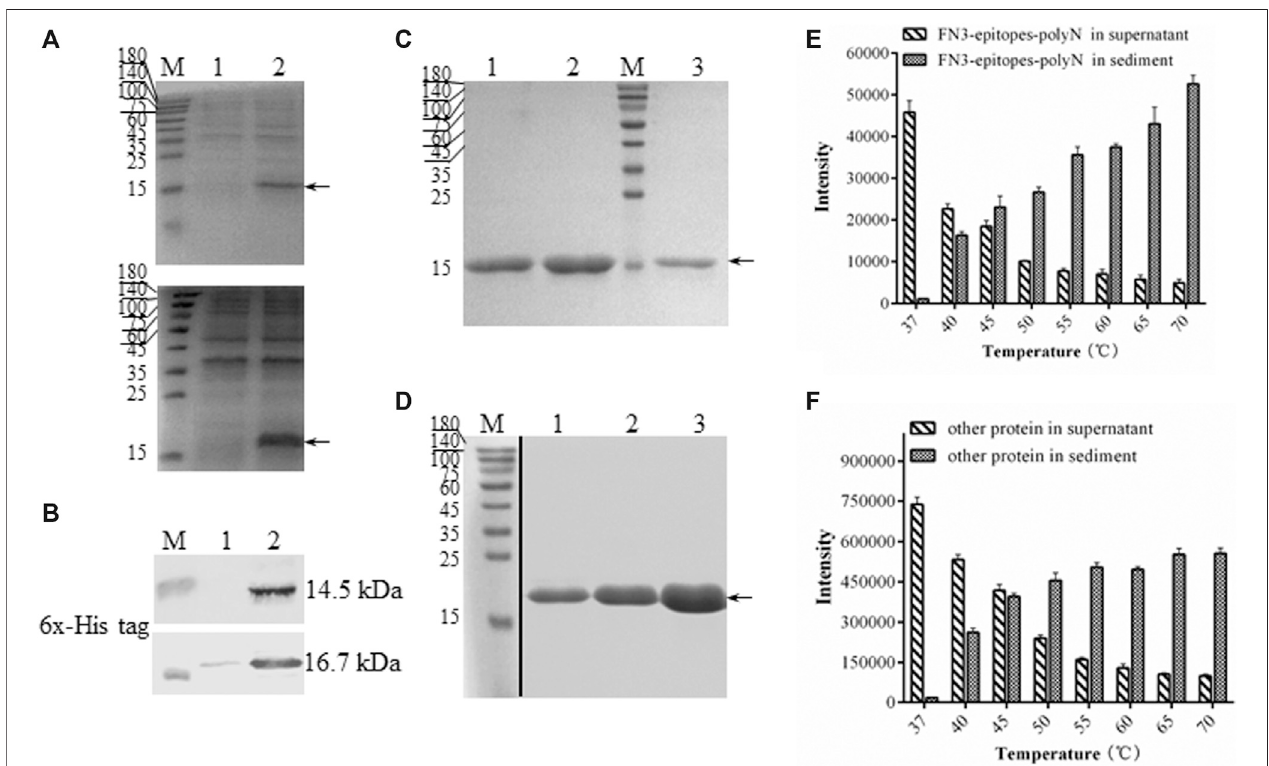
FIGURE3| Thesolubilityandpuri fi cation ofrecombinant FN3-epitopes. (A) SDS-PAGEanalysisofthesolubleexpression ofFN3-epitopes-4GS(upperpanel)and FN3-epitopes-polyN (lowerpanel) in E.coli BL21 (DE3).Arrow indicates thetarget protein FN3-epitopes-4GS (14.5 kDa) orFN3-epitopes-polyN (16.7 kDa). Lane 1:the precipitateoftotalproteinlysates;Lane2:thesupernatant oftotalproteinlysates. ( B )Westernblotanalysisofthesolubleexpression ofFN3-epitopes-4GS(upperpanel) and FN3-epitopes-polyN (lower panel) in E. coli BL21 (DE3). Lane 1: the precipitate of total protein lysates; Lane 2: the supernatant of total protein lysates. ( C, D ) SDS-PAGE analysis of the isolation of FN3-epitopes-4GS (C) and FN3-epitopes-polyN (D) via the HisTrap ™ puri fi cation. Arrow indicates the target protein FN3- epitopes-4GS (14.5 kDa) or FN3-epitopes-polyN (16.7 kDa). Lanes 1 – 3 in (C): protein from three tubes eluted sequentially using 60 mM imidazole; lanes 1 – 3 in (D): proteinfrom threetubes elutedsequentiallyusing 80 mM imidazole.M: molecular marker.( E,F ) Histogram depictingthethermal degradation ofFN3-epitopes-polyN(E) and other proteins except FN3-epitopes-polyN (F). Signal intensities calculated from SDS-PAGE images in Supplementary Fig. 2. Data correspond to averages of three independent experiments. Error bars represent standard deviations. M: molecular